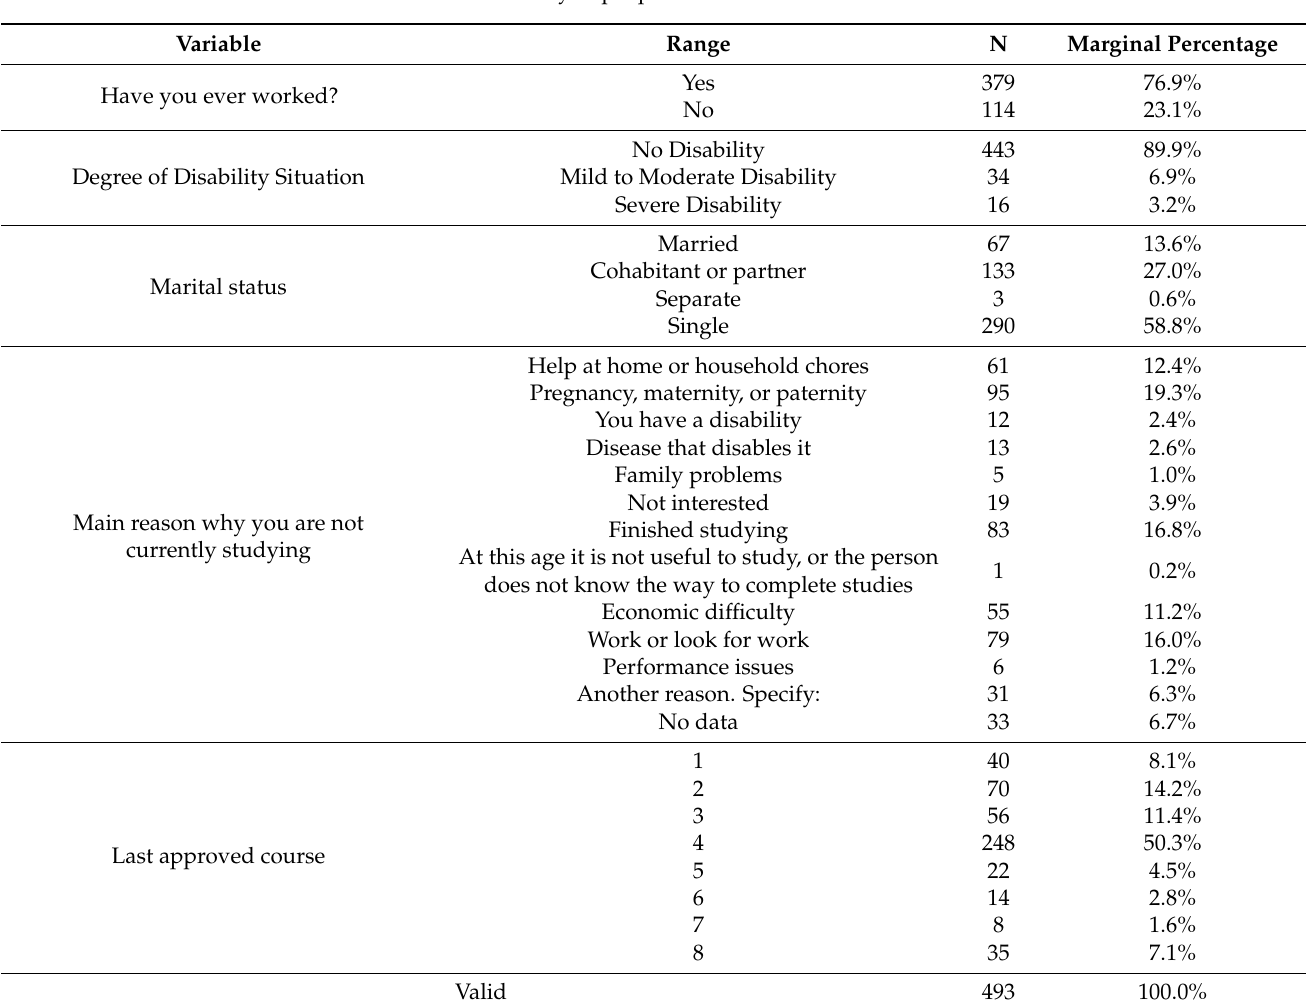
Table 2. Summary of people with disabilities in